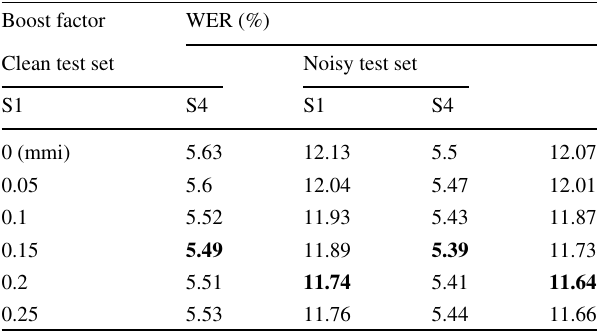
Boost factor WER (%)